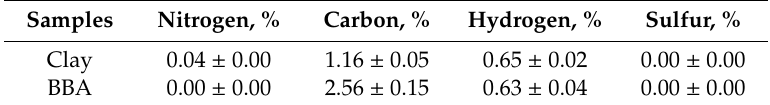
Table 3. Elemental analysis carbon, hydrogen, nitrogen and sulfur for clay and biomass bottom